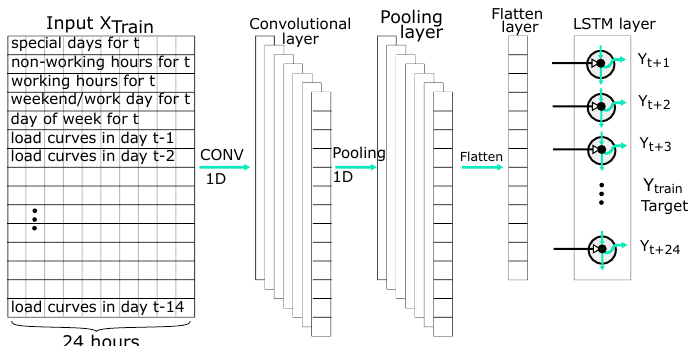
Figure 12. Structure of CNN—LSTM.